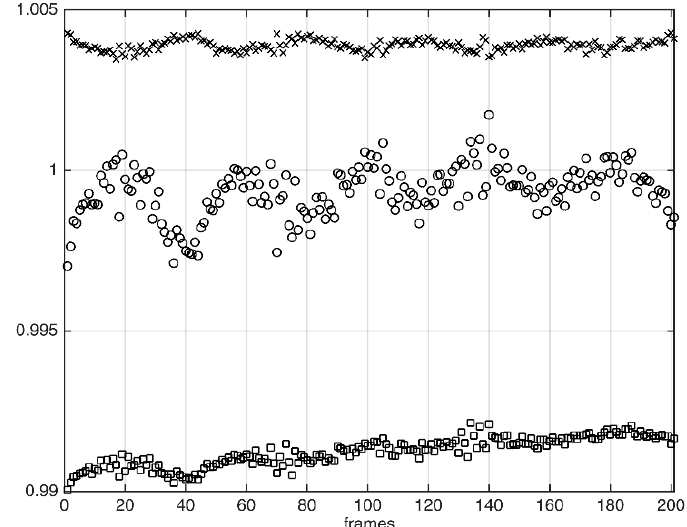
Figure 5. Quotient between the computed and the theoretical parameters of the location vector ( x c (crosses), y c (squares), β (circles)) for the frames of the above simulated sequence.